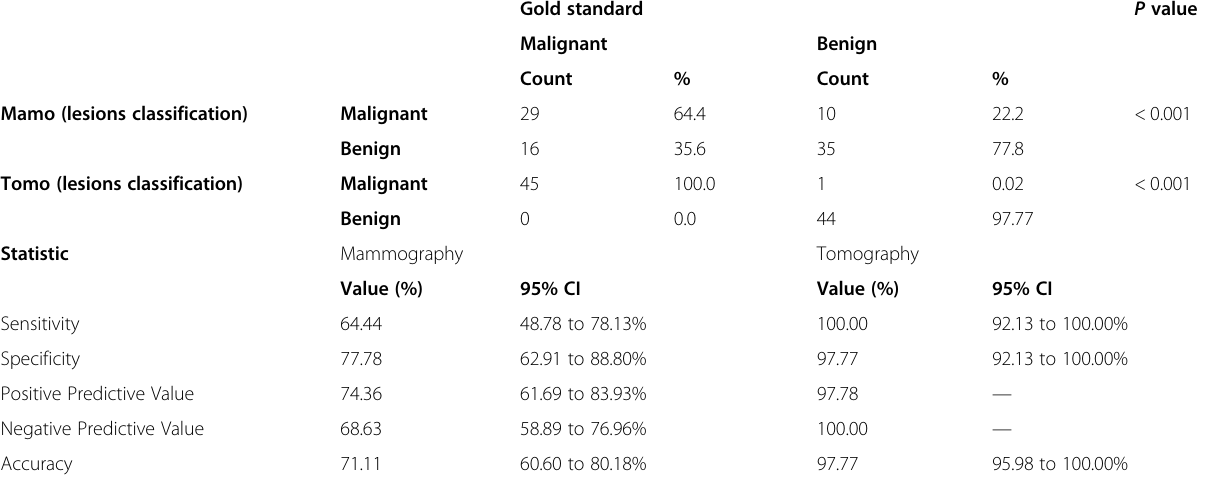
Table 3 Comparison of a diagnostic performance and indices of mammography and tomosynthesis